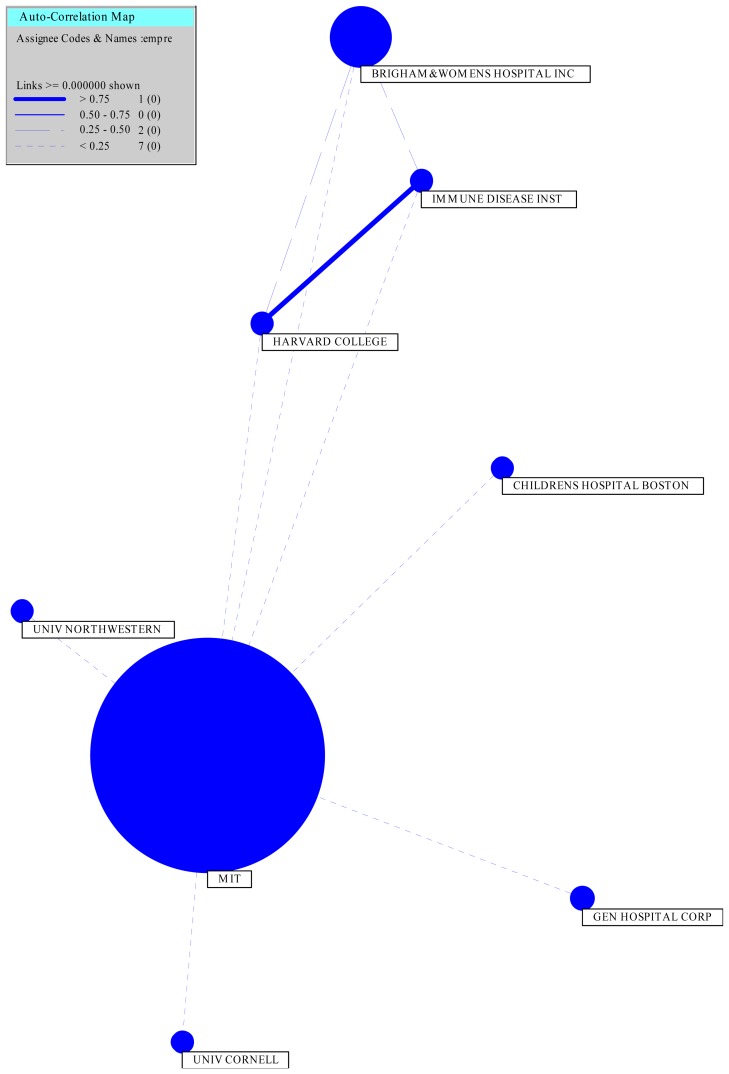
MIT partnerships.